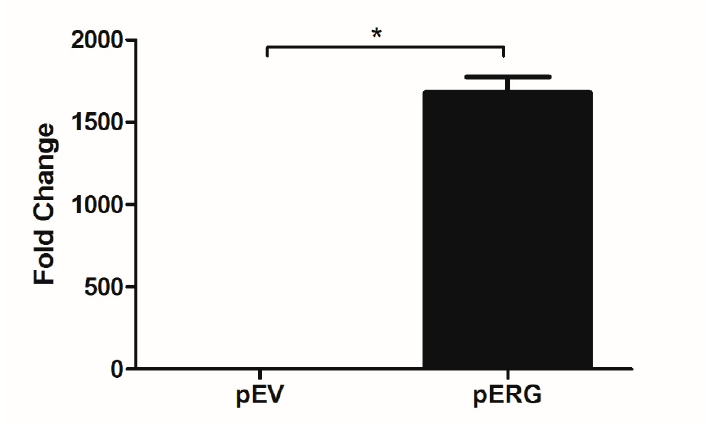
Figure 1. Expression analysis of ERG in H358 cell line transfected with pEV and pERG plasmids using qRT-PCR (*: p <